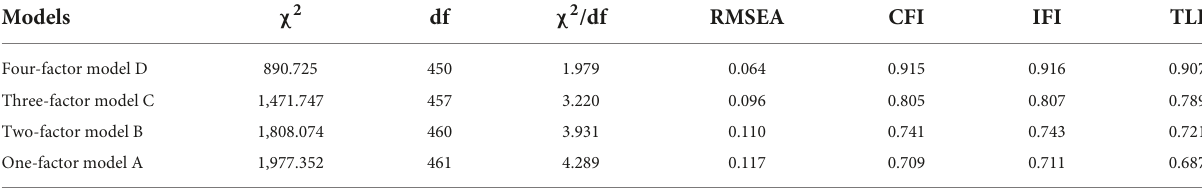
TABLE 1 AMOS confirmatory factor analysis.